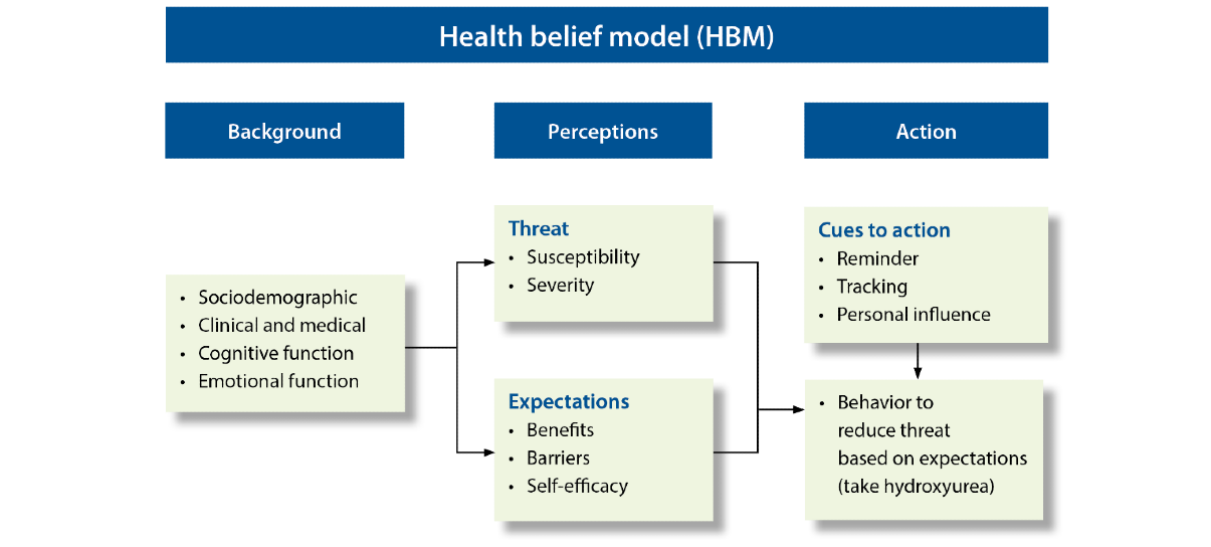
Figure 1. Health belief model applied to hydroxyurea